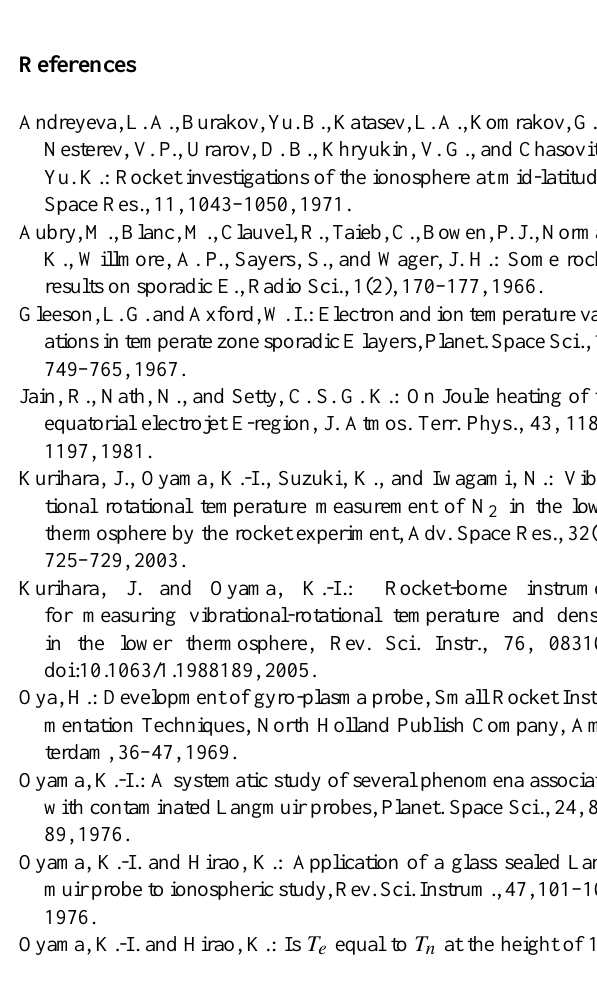
Fig.6c. Same as Fig.6a but for H., G, and I ,which are marked in Fig.5.